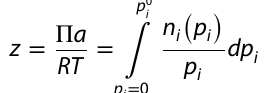
Fig. 14 Breakthrough curve (BTC) for Ni-MOF-74@Al dence time distribution (RTD) for inert silica spheres of a binary CH /CO mixture ( y CO = 0.25) at T = 303.15 K, p = 5 bar and a flow 4 2 2 rate of 50 mL min −1 (STP) on a fixed bed ( L bed = 15 cm, d bed = 1.5